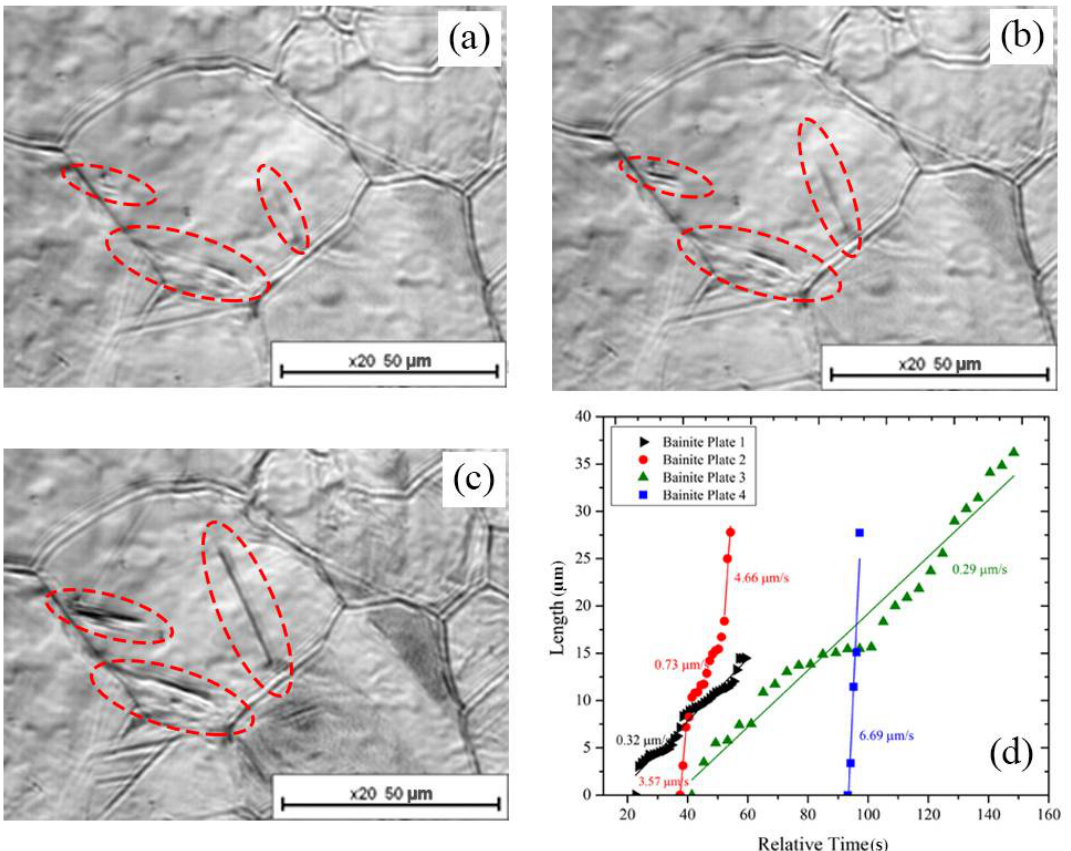
Figure 7. ( a – c ) Micrographs showing the growth of bainitic ferrite plates during holding at 923 K (650 °C) at various stages of the isothermal holding time and ( d ) length versus time plot of the corresponding plates and their lengthening rate.